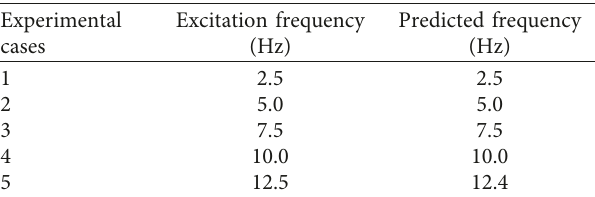
Table 1: Summary of the verification test result.